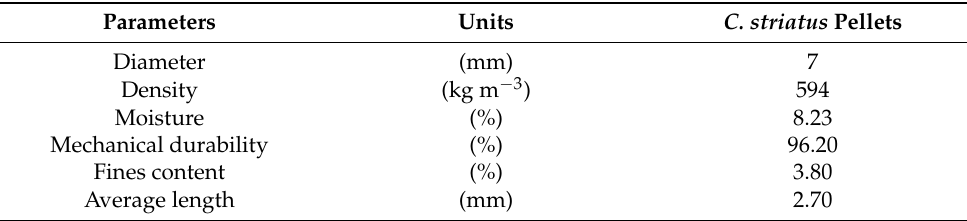
Table 2. Physical properties of C. striatus pellets.